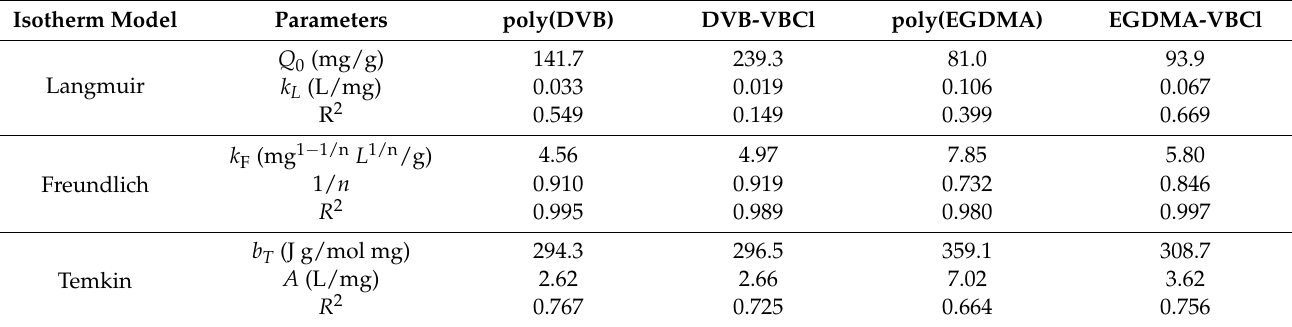
Table 2. The parameters of Langmuir, Freundlich and Temkin isotherm models calculated using linear regression for the investigated adsorption